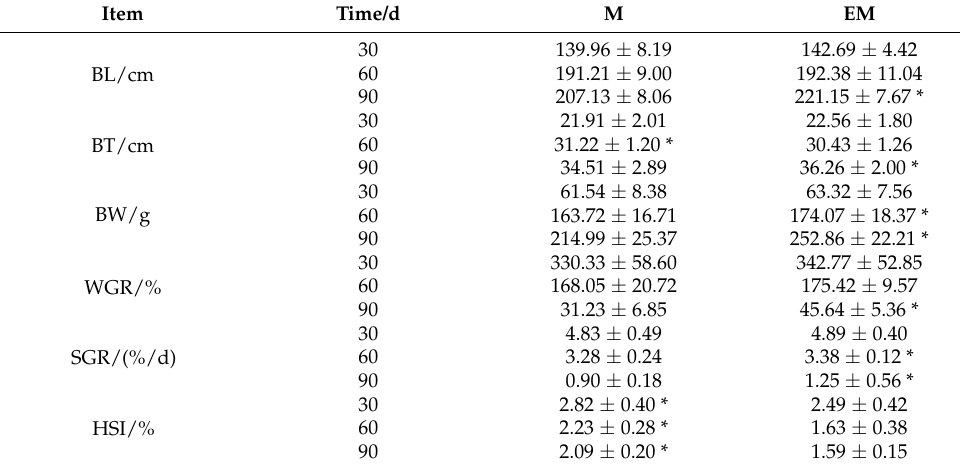
Table 1. Growth performance and morphological indices of largemouth